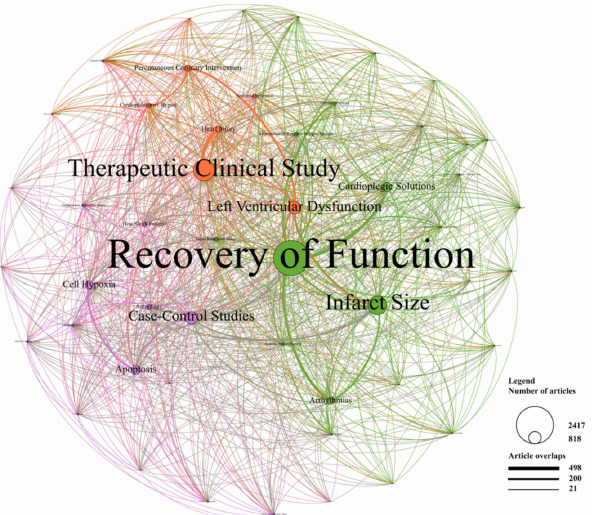
Figure 7. Topic cluster network by Latent Dirichlet allocation. The green region represents the cluster of prognosis, the purple region represents the cluster of mechanism, and the red region represents the cluster of treatment. The size of the circle represents the number of publications in each topic, and the degree of line thickness represents the weight of connections between